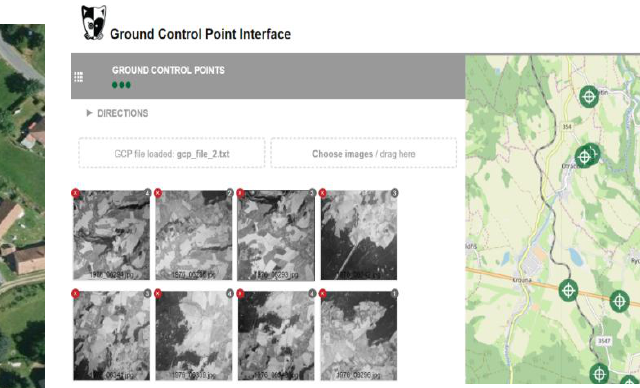
Figure 10a. Situation of a current orthophoto